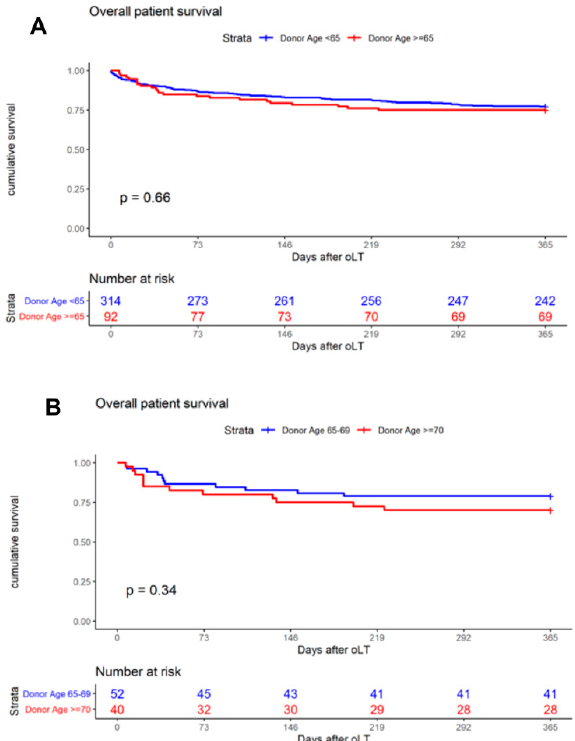
Figure 2. Kaplan–Meier curves demonstrate the impact on one-year patient survival of ( A ) donor age < 65 and ≥ 65 years; ( B ) donor age ≥ 65–69 and ≥ 70 years.